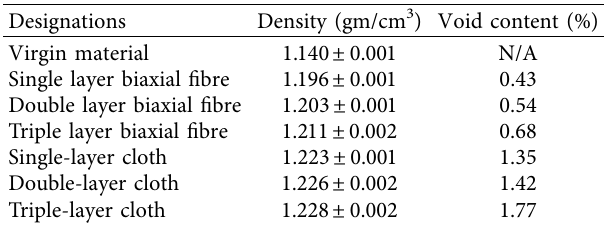
Figure 10: Universal tribometer with heat chamber. Table 1: Density and void content of prepared